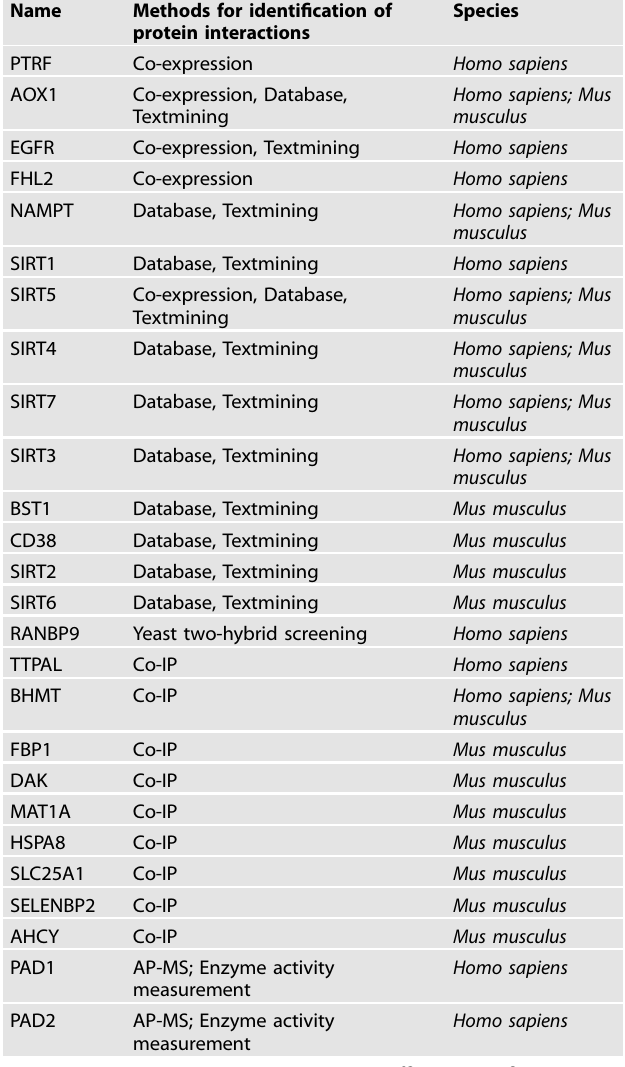
Table 3. The interacting proteins of NNMT. Name Methods for identi fi cation of protein